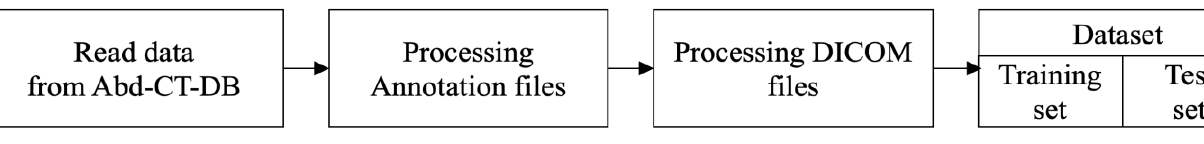
Figure 1. The processing flow of annotation and DICOM files for creating the dataset for use in DL.